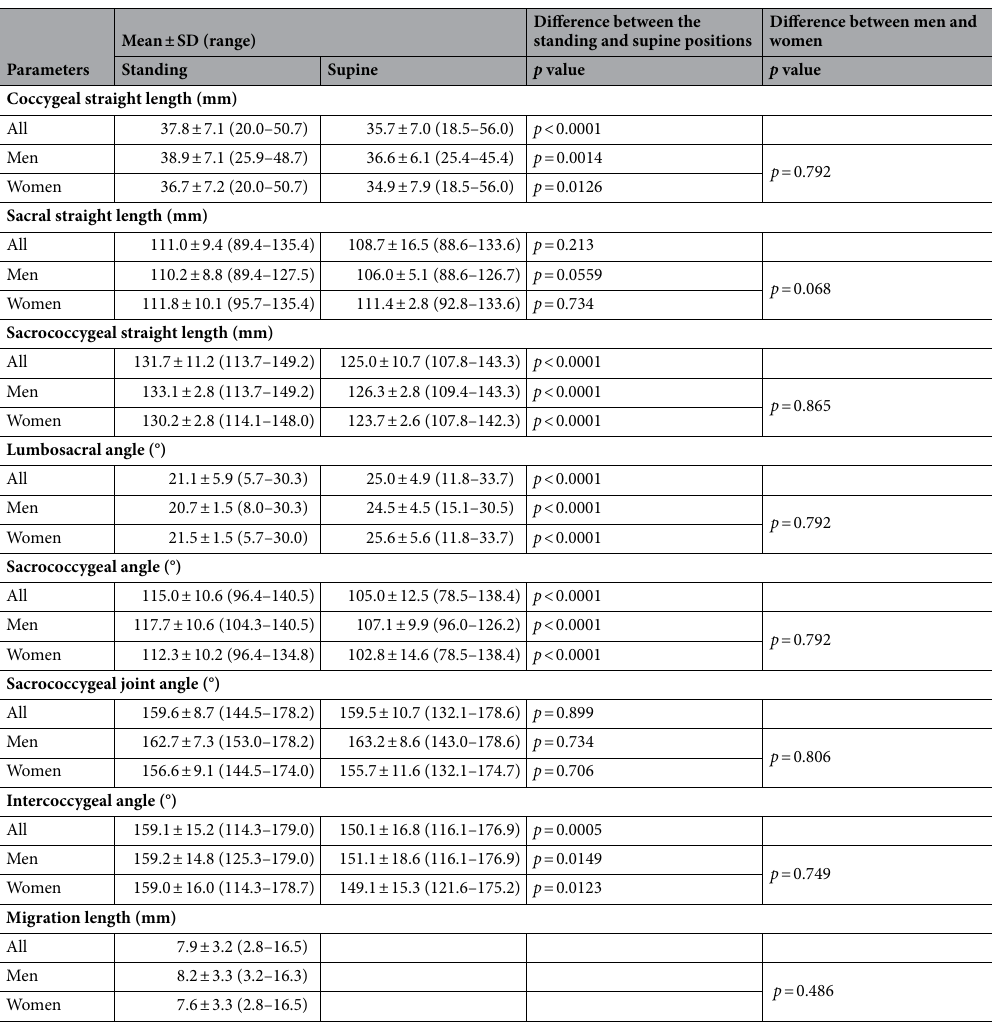
Table 3. Summary statistics for parameters in the standing and supine